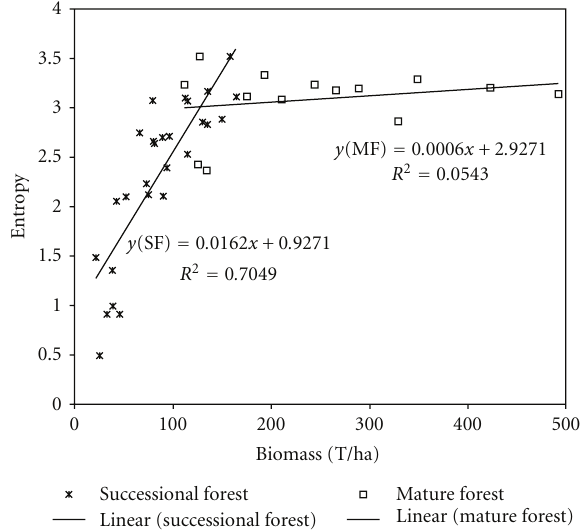
Figure 1: Comparison of aboveground biomass-entropy relation- ships in successional and mature forests in Machadinho d’Oeste in northeastern Rondˆonia,